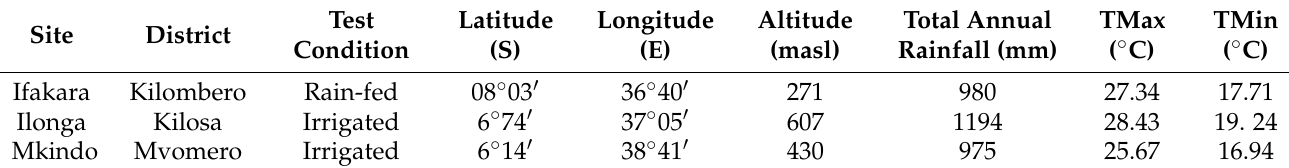
Table 2. Descriptions of the three sites used for evaluation of 45 crosses and 10 parents.